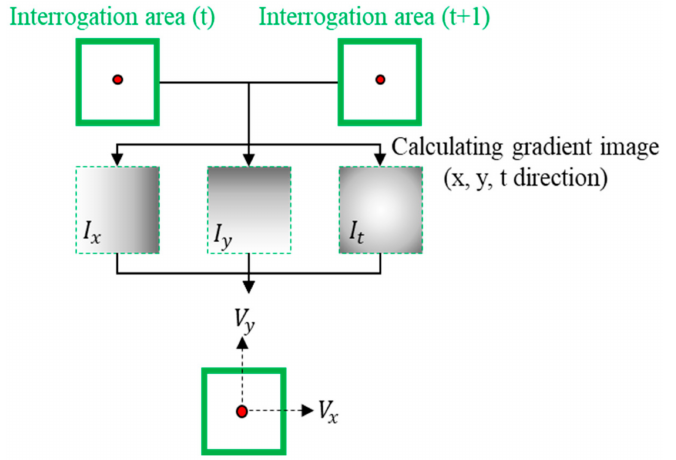
Figure 3. Procedure of the optical flow algorithm to calculate the velocity at a grid